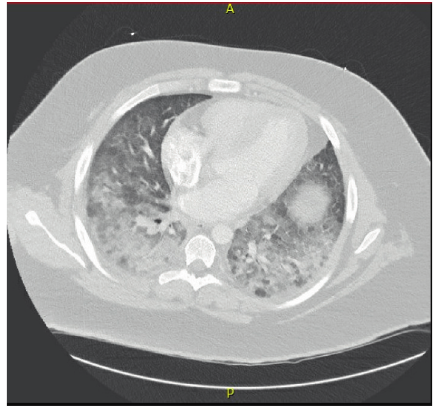
Figure 2: Chest CT angiography showing diffuse symmetric ground-glass opacities with confluent consolidation within both lower